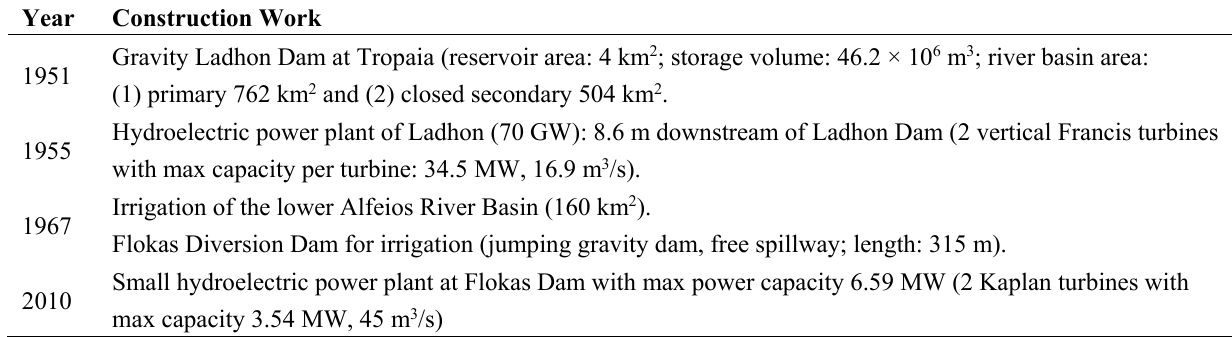
Table 1. Main water constructions linked to the major water users in the Alfeios River